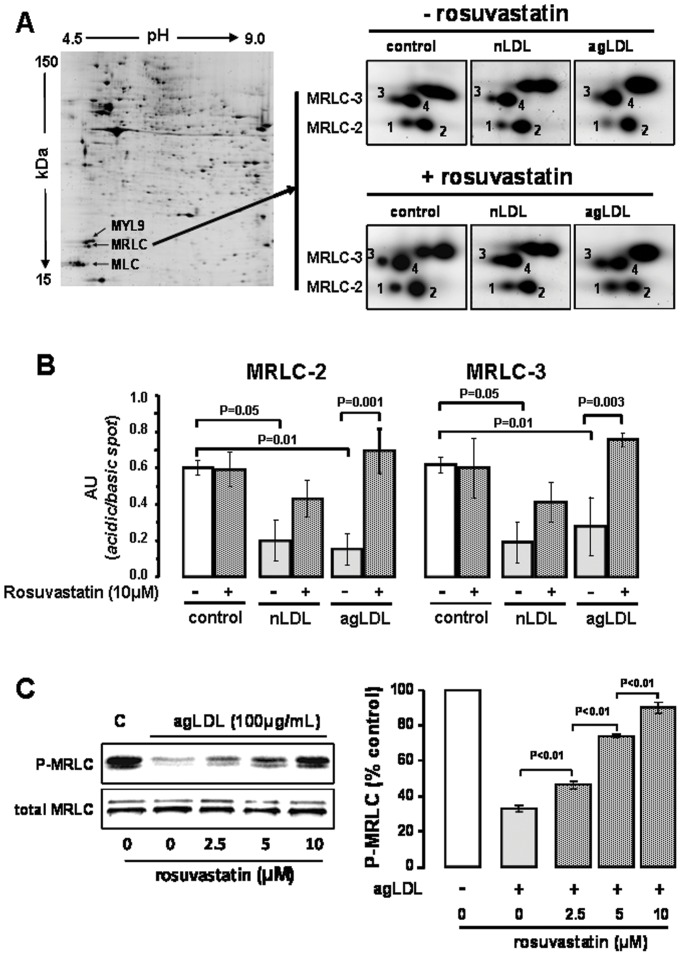
Rosuvastatin prevents MRLC dephosphorylation in VSMC exposed to LDL.(A) Representative 2-DE gel of the cytoskeleton/membrane fraction. Arrows show spots identified as MYL9 (sarcomeric-MRLC), non-sarcomeric-MRLC (MRLC) and alkali-MLC (MLC). Enlarged images for the proteomic pattern of the non-sarcomeric MRLC isoforms (MRLC-2, spot 1–2 and MRLC-3 spots 3–4). Note that numbers 1–2 and 3–4 denote double spots with different pI of the non-sarcomeric MRLC isoforms. (B) Bar-diagrams for ratios between the intensity of the spot with lower pI and the correspondent with higher pI. Results given as mean±SEM (n=3). P values for Man-Whitney test; only shown differences for P<0.05 (C) Western blot for phosporylated-MRLC (P-MRLC) and total MRLC in extracts of VSMC exposed to agLDL in the presence of different dose of rosuvastatin (2.5–10 µM). C denotes the control group. Bar diagram represents quantitative values (mean±SEM) of 3 independent experiments. P values for Man-Whitney test.